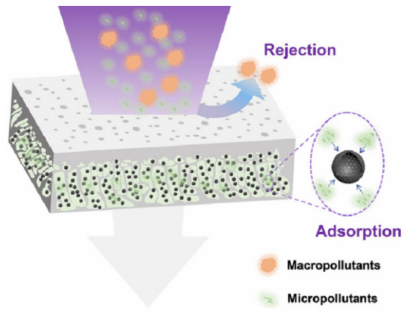
Figure 1. The purification process for multiple pollutants polluted water by DFUF membrane. Reprinted/adapted with permission from Ref. [43]. Copyright © 2020